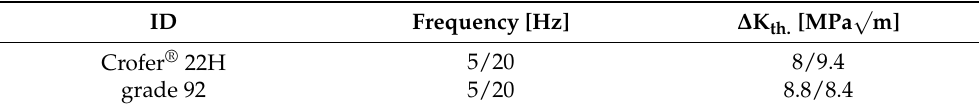
Table 3. Frequency dependency of the threshold values ( ∆ K th. ) of Crofer 22H (PA) and grade 92 (650 ◦ C).